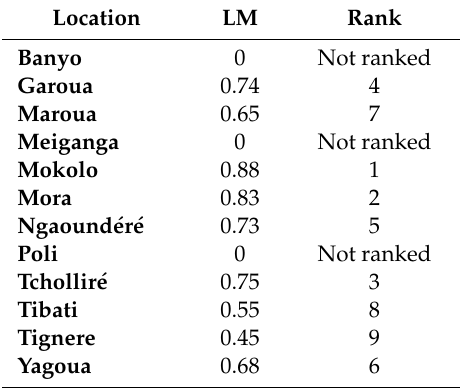
Figure 8. Factor measures (critical factor measure (CFM), suitability factor measure (SFM), & objective factor measure (OFM)) of each location. Table 13. Location measures and ranking of alternative